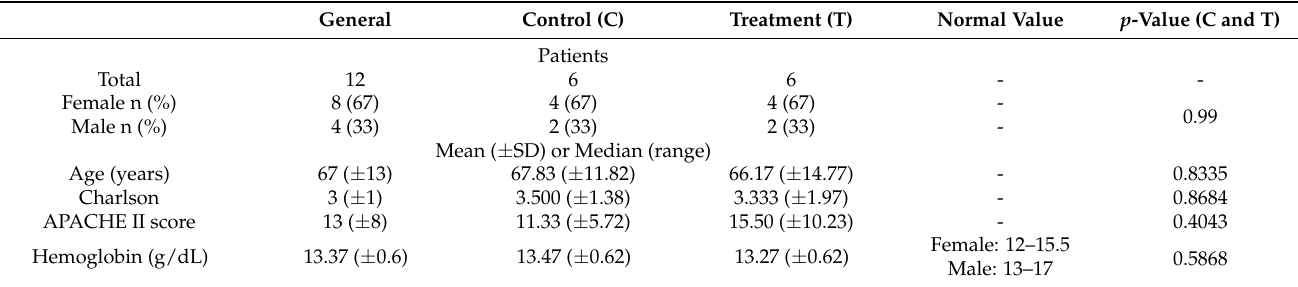
Table 1. Baseline characteristics overall (general), patients with Tocilizumab (treatment) and their matched controls respectively